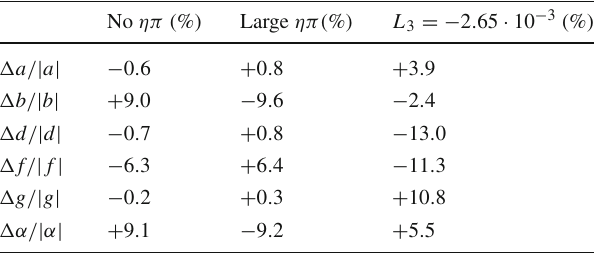
olations based on single-channel and coupled-channel Khuri–Treiman equations and the matching procedure described in the text. The last two columns show experimental results from Refs. [15,16,54]